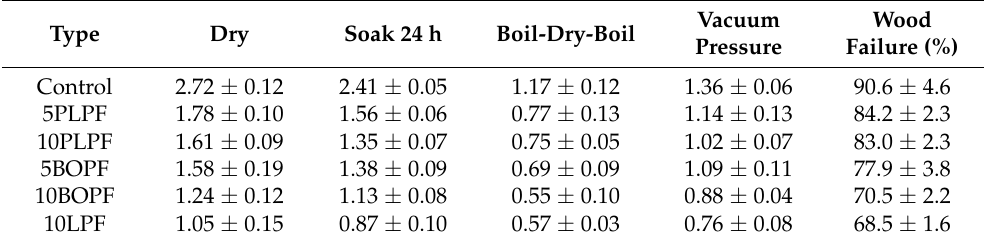
Table 5. Shear strength and wood failure of rubberwood plywood bonded with EFB